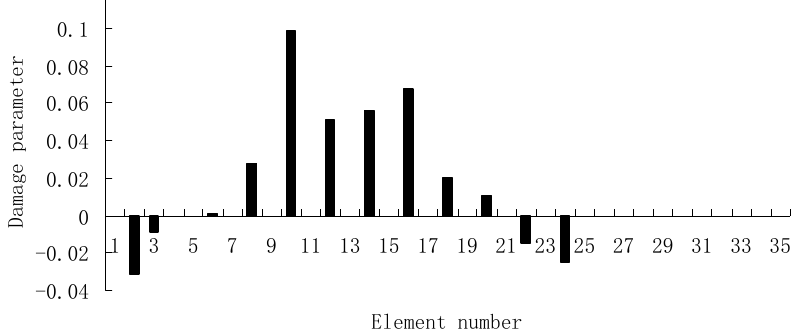
Figure 4. Damage evaluation result by the first computation of enhanced singular value truncation (ESVT) for case 1 (element 10 had 20% stiffness reduction).